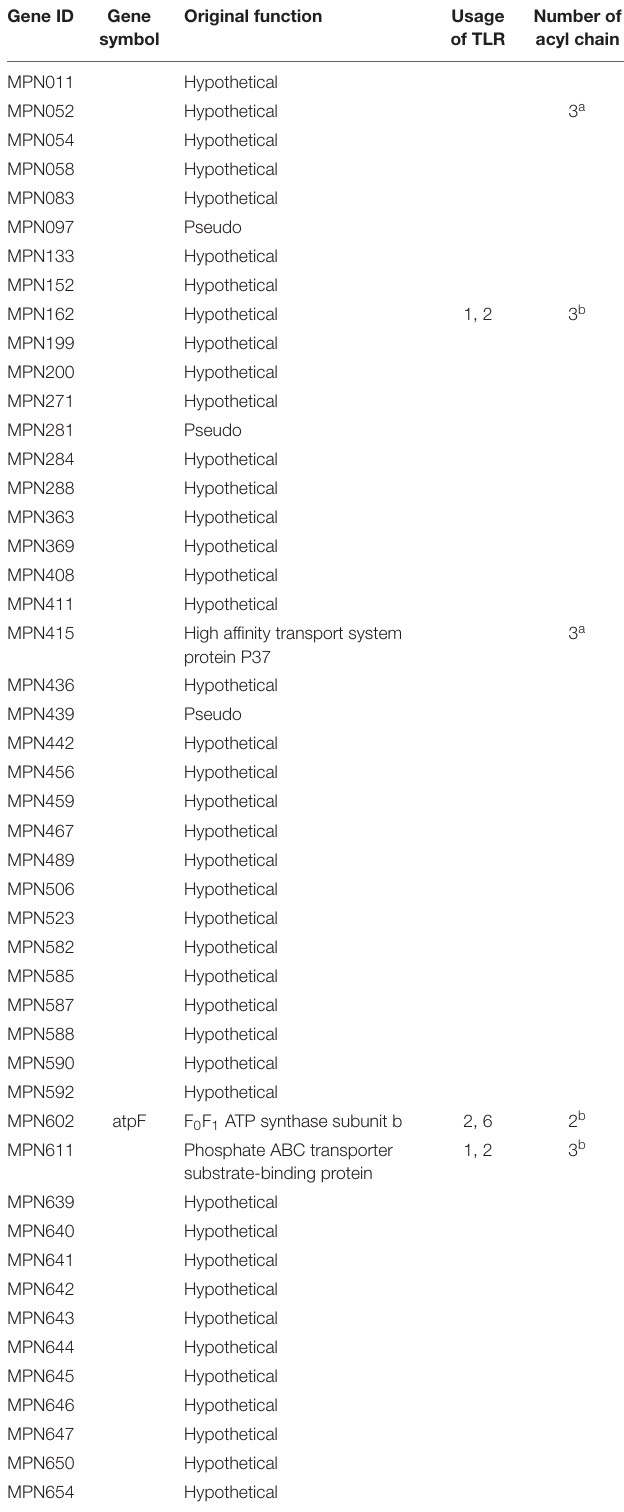
TABLE 2 | Summary of lipoproteins of M.